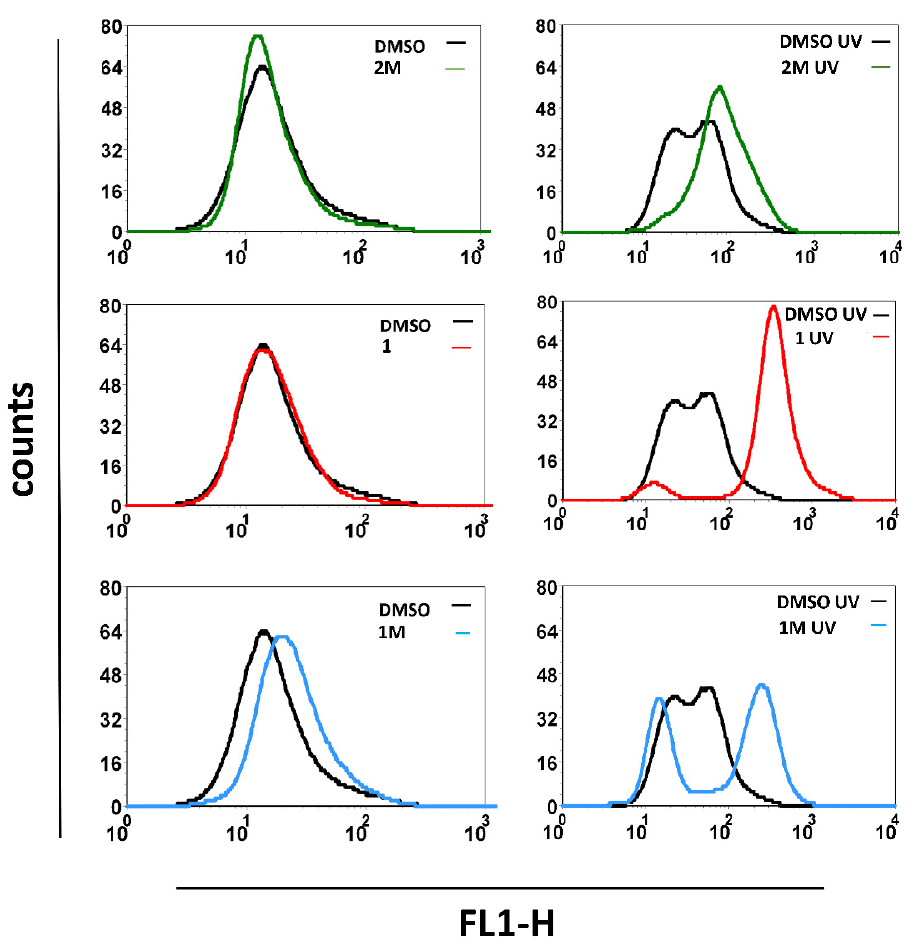
Figure 8. The amount of ROS in A549 cells treated with 10 µM 2M , 1 , or 1M , with or without UV light irradiation. Levels of ROS were assessed by measuring the fluorescence intensity of a DCF stain by flow cytometry. The black line represents control cells, i.e., cells treated with DMSO. Coloured lines represent cells treated with 2M , 1 , or 1M , respectively. Representative data from two independent experiments are shown, both yielding similar results.